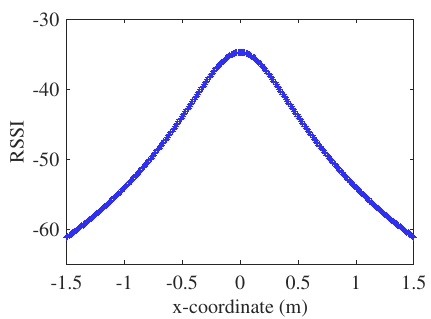
Figure 3. The theoretical RSSI value when a tag moves along the